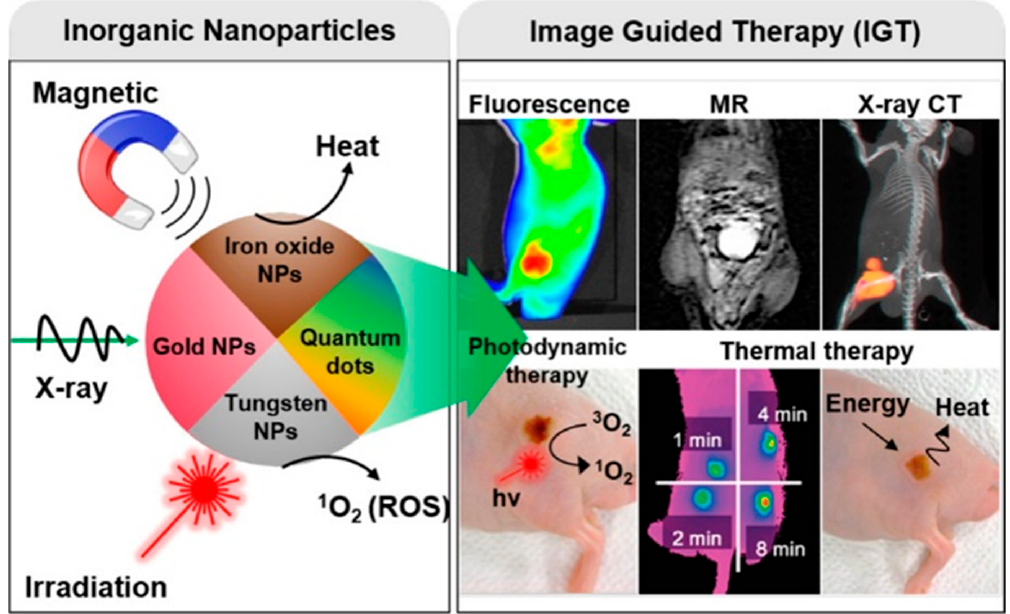
Figure 6. Inorganic NP for tumor imaging and therapy. Reproduced with permission from Reference [180]. Copyright 2017 American Chemical Society.